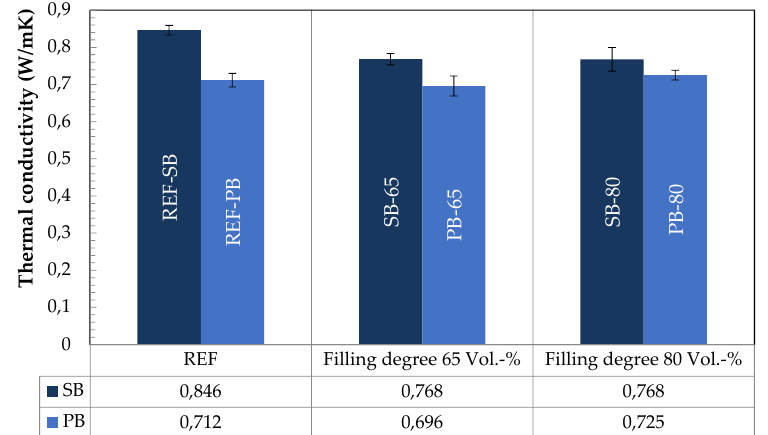
Figure 2. Thermal conductivity of the SB- and PB-RBA mortars, with and without